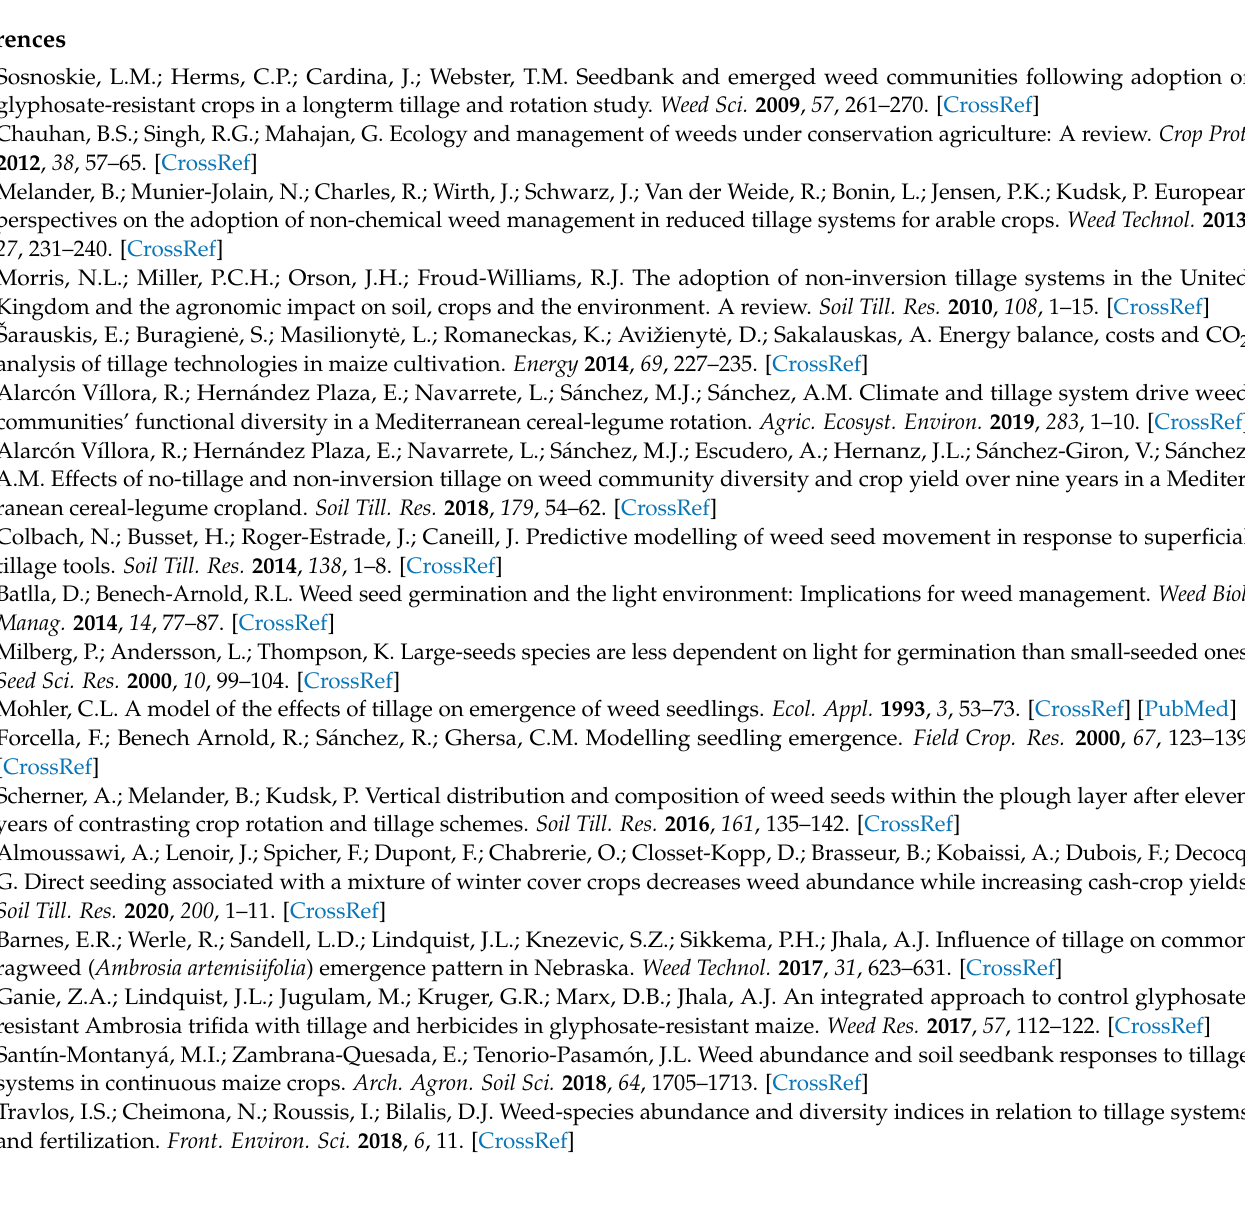
Table S4: The most widespread weed seedbank (thousand weed seeds m − 2 ) in different soil layers, as influenced by the tillage system in